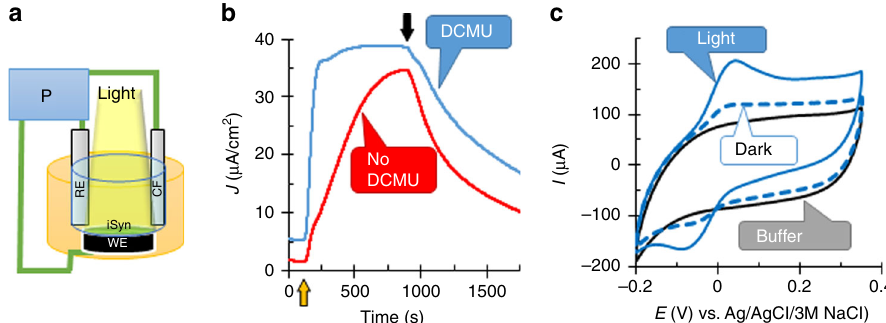
Fig. 2 Gently treated Synechocystis cells generate an enhanced photocurrent using an endogenous redox mediator. a Schematic drawing of the bio photo- electrochemical apparatus with the iSyn settled on the working electrode (WE). The counter electrode (CE) is platinum, and the reference electrode (RE) an Ag/AgCl/3 M NaCl. All electrodes are connected to the potentiostat (P). b Chronoamperometric measurements at 150 mV (vs. Ag/AgCl/3 M NaCl) for iSyn in the presence (blue) or absence of DCMU (red). The yellow up arrow indicates light on (the initial 100 seconds show the dark current) and the black down arrow indicates light off. c Cyclic voltammograms of iSyn, illuminated (solid blue lines) or in the dark (dashed blue lines). Buffer lacking iSyn shows no redox activity (black solid line). Measurements recorded at a rate of 5 mV s − 1